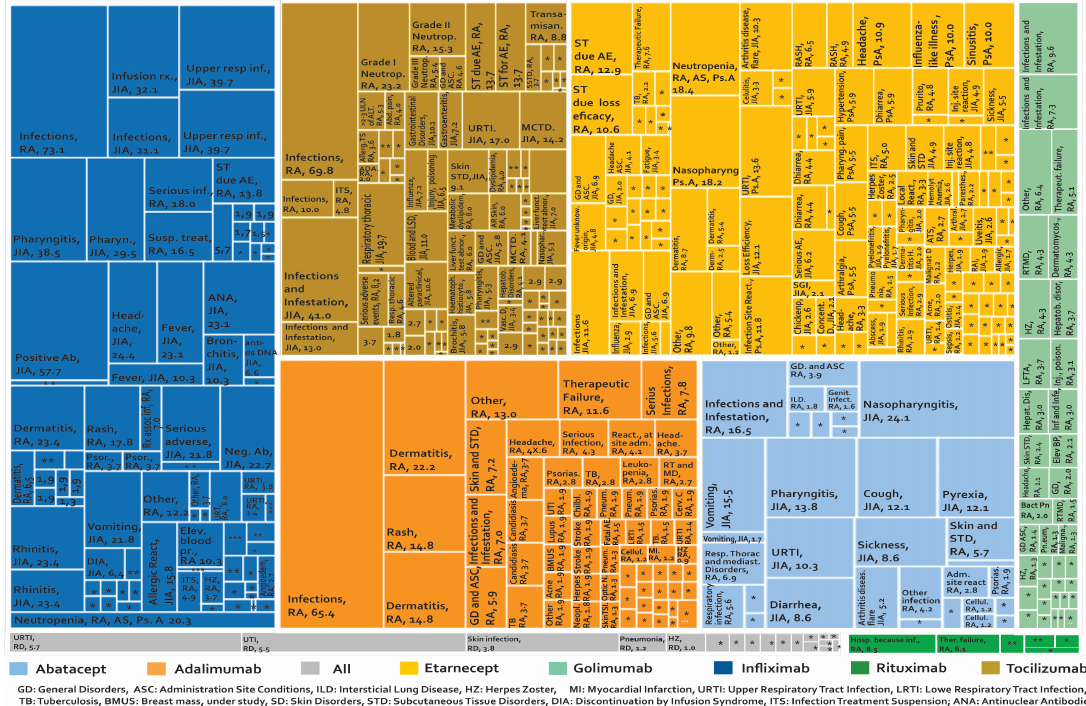
Figure 7. Adverse biotherapeutic events in rheumatic diseases presented in cohort studies (presented by percentages) [6,21,55,108–152]